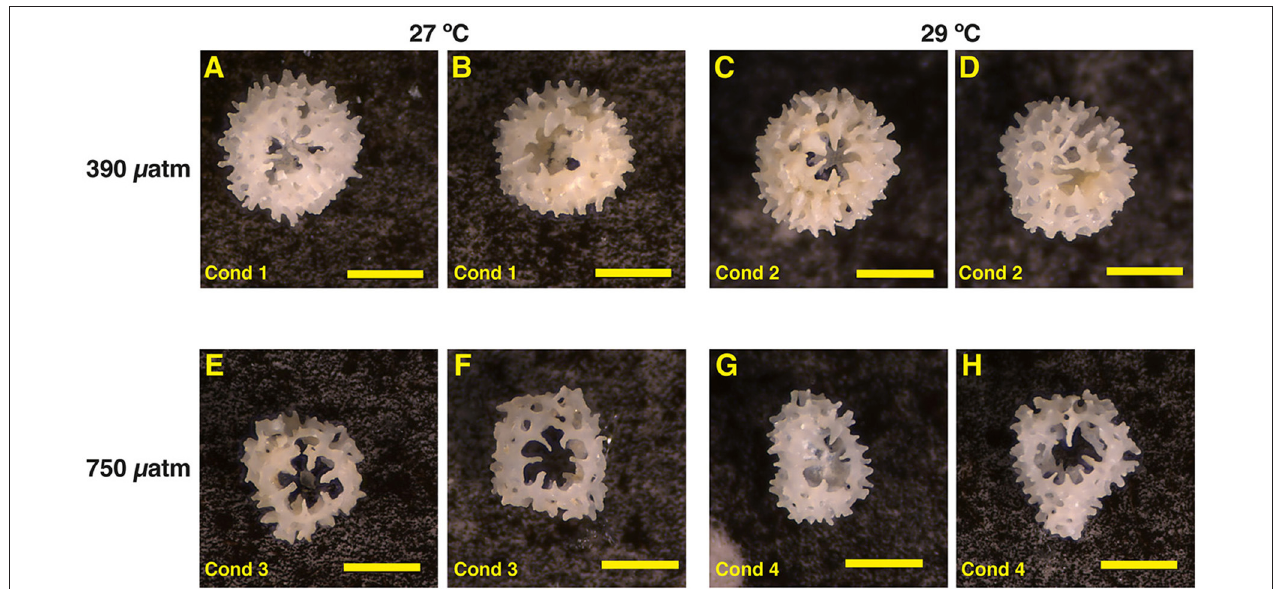
FIGURE 2 | Photographs of representative individual primary polyp A. millepora juvenile corals (single corallite) cultured in the four experimental conditions (Table 1). (A,B) Condition 1 (control) revealing normal skeletal material. (C,D) Condition 2 with more translucent skeletal characteristics relative to condition 1. (E,F) Condition 3 with decreased bulk volume and skeletal material. (G,H) Condition 4 with more asymmetrical, translucent, and brittle skeletal material. All scale bars are 500 µ m.